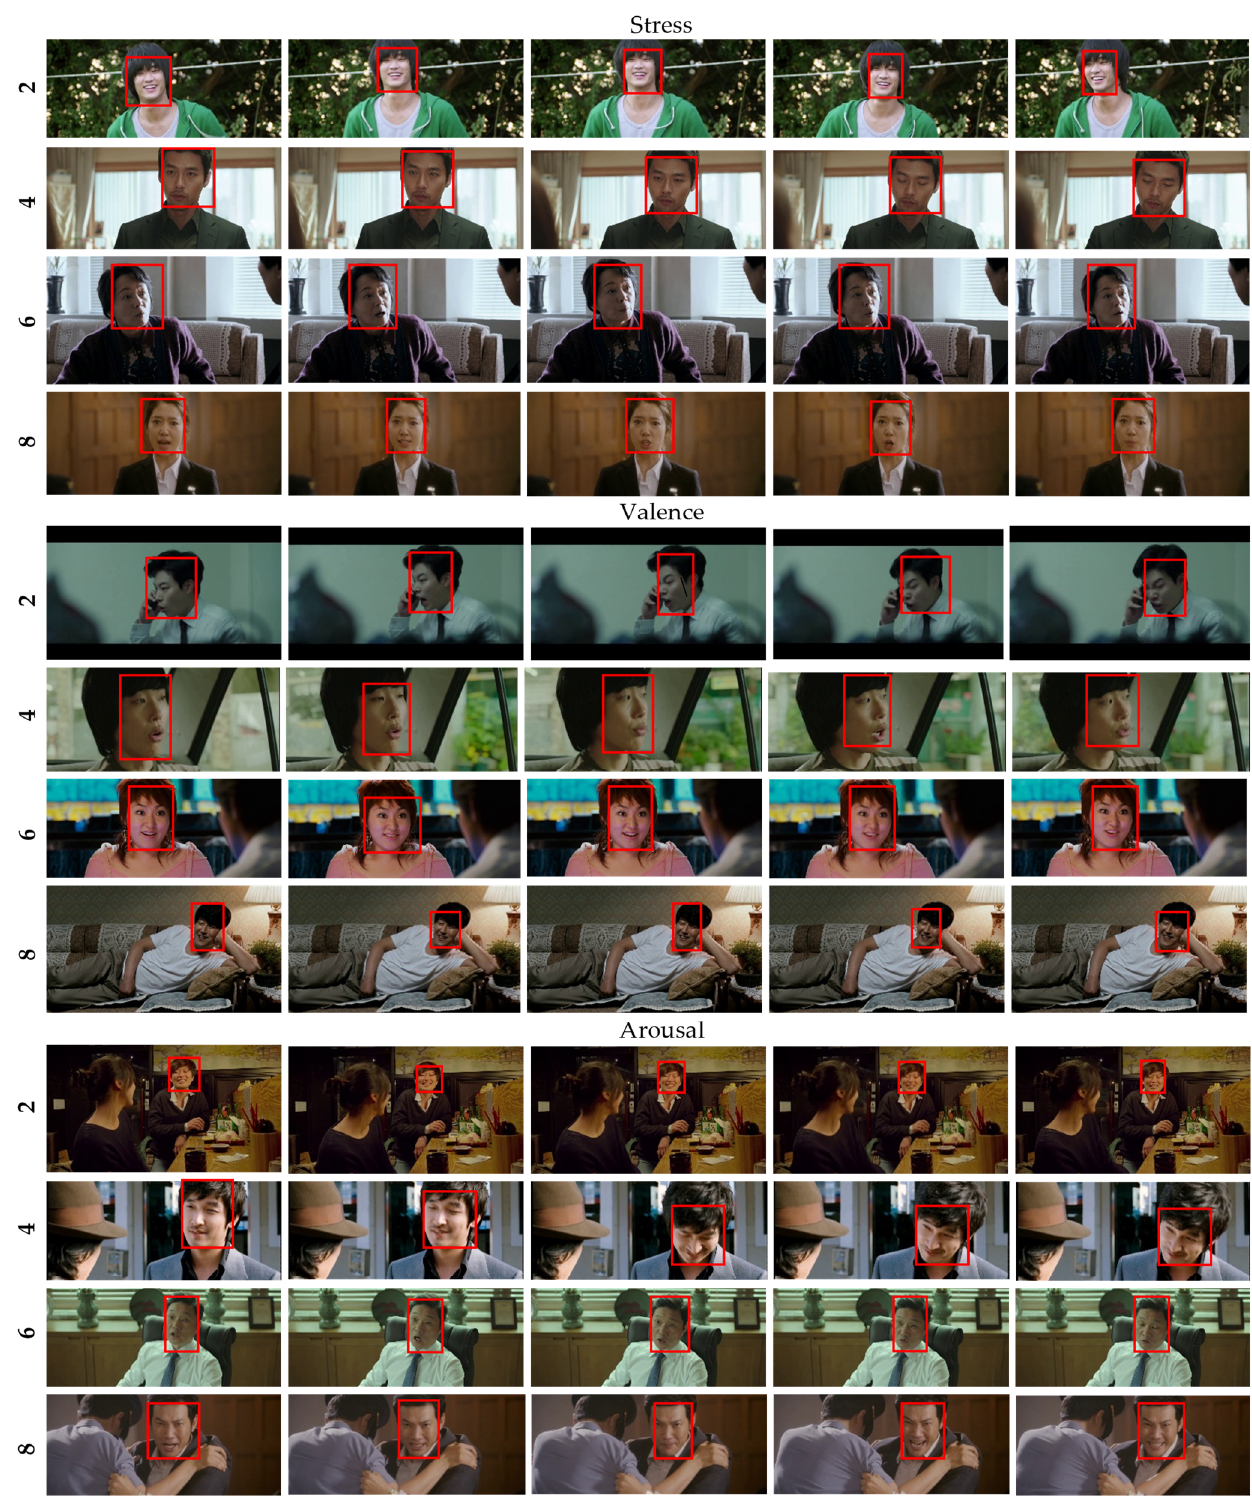
Figure 2. Examples of different scores of valence, arousal, and stress in the SADVAW dataset. The first four rows present examples for stress values, the next four rows include examples for valence values, and the last four rows show examples for arousal values. Each row consists of the sequence of frames of a video with the corresponding annotated value on the left. The value range of stress, valence, and arousal is from 1 to 9. Here, we only present the videos with some representative values (2–4–6–8) for each class.